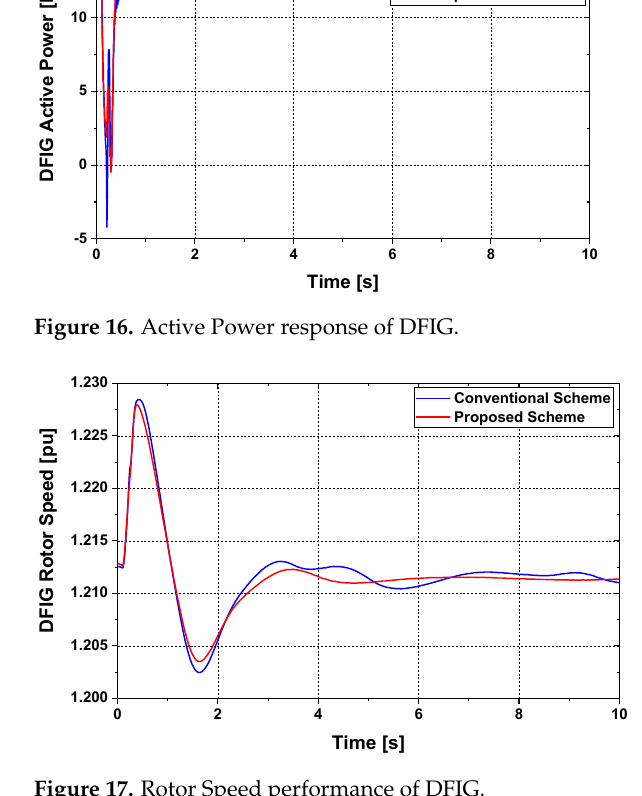
Figure 17. Rotor Speed performance of DFIG.